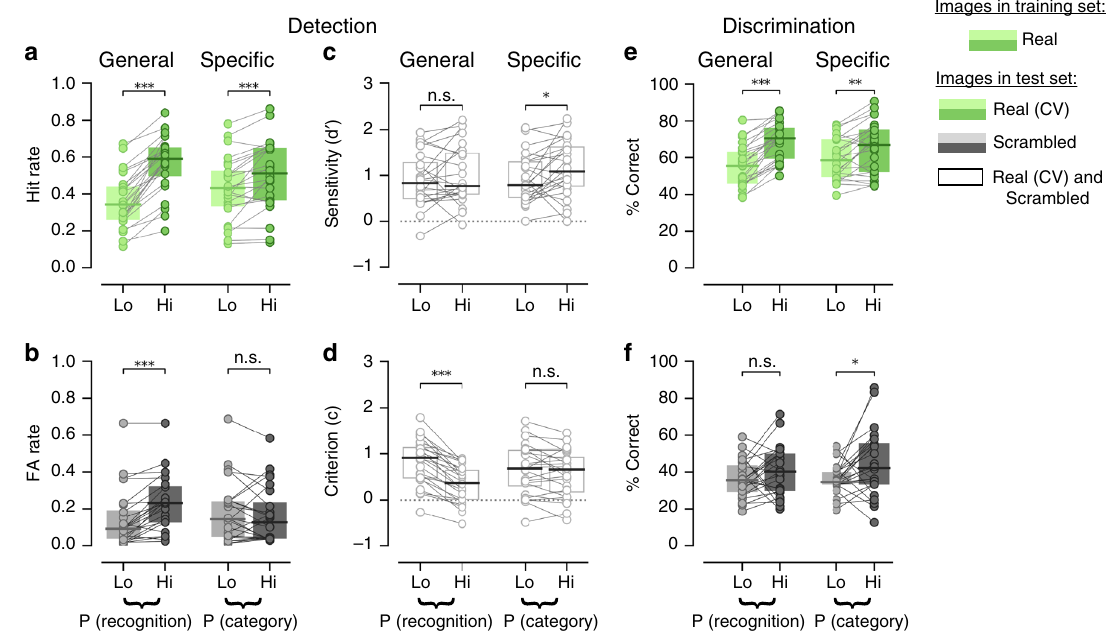
Fig. 4 The predictions made by the General and Speci fi c models differentially bias the SDT metrics. a – d Show the metrics of detection (based on subjective recognition reports: “ yes ” or “ no ” ) and e – f show the metrics of discrimination (based on subjective stimulus category reports: “ Face ” , “ House ” , “ Object ” , or “ Animal ” ). a Recognition rates as a function of predictions made by the General and Speci fi c (cross-validated, CV) neural process in real-image trials (Hit Rate). b Same as a but for scrambled-image trials (False Alarm rate) while the models were fi t in real-image trials. c SDT sensitivity (d ′ ) as a function of predictions made by the General and Speci fi c neural process. d SDT criterion ( c ) as a function of predictions made by the General and Speci fi c neural process. e Percent of correct subjective stimulus category reports for the two models in real-image trials (cross-validated, CV). f Percent of correct subjective stimulus category reports for the two models in scrambled-image trials, while the model was fi t in real-image trials only. Wilcoxon signed-rank test was used to assess the difference between the groups in a , b , e , f and paired t -test to assess the difference between groups in c , d ( N = 24). See Supplementary Figure 3 for details on how trials were split into high and low probability groups. Source data are provided as a Source Data fi